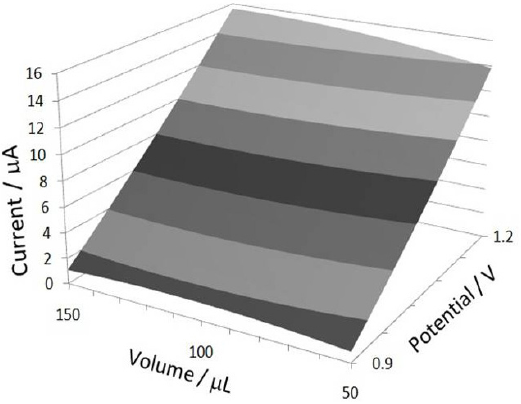
Figure 2. Surface response for fitted model.